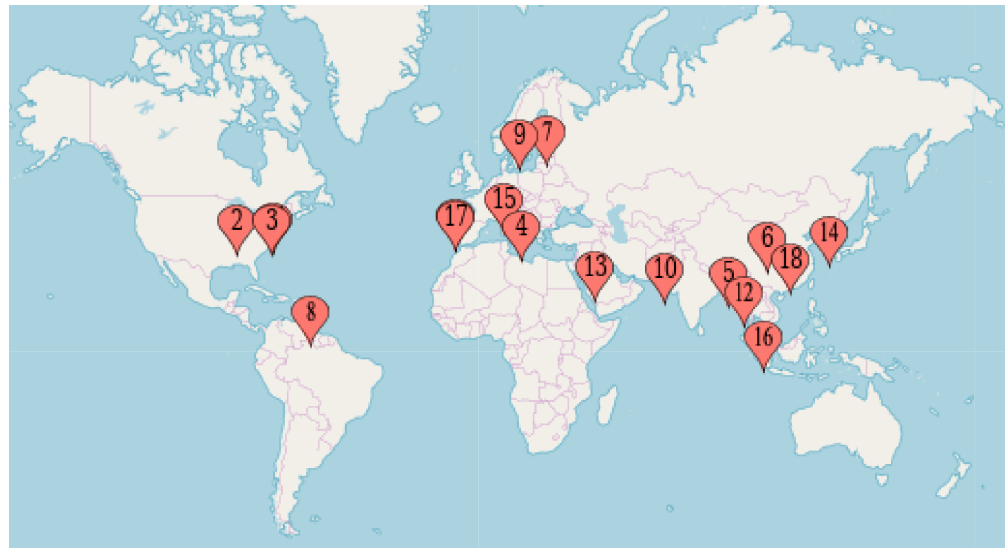
Figure 2. Dispersion of the different studies by